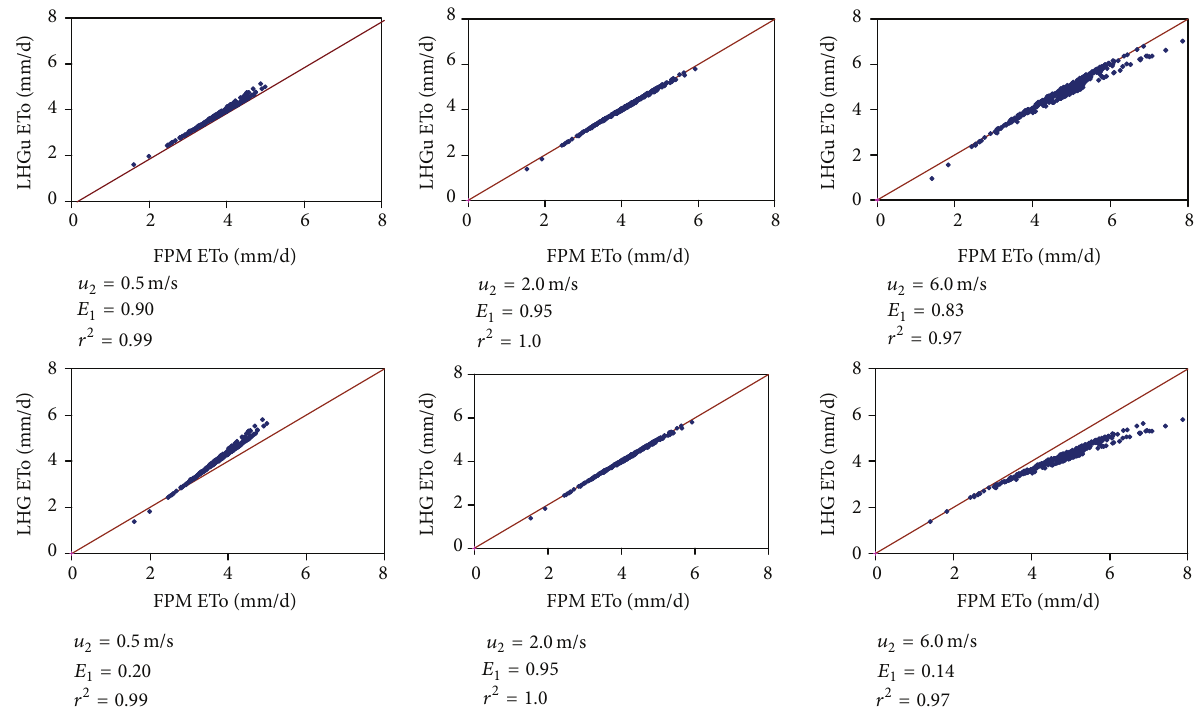
Figure 2: Scatter plots of LHGu and LHG versus FPM applied to 2007 Accra site data at three sample constant daily 𝑢 2 values, showing 𝑟 2 , 𝐸 1 , and scatter plot alignments with the 1:1 lines.